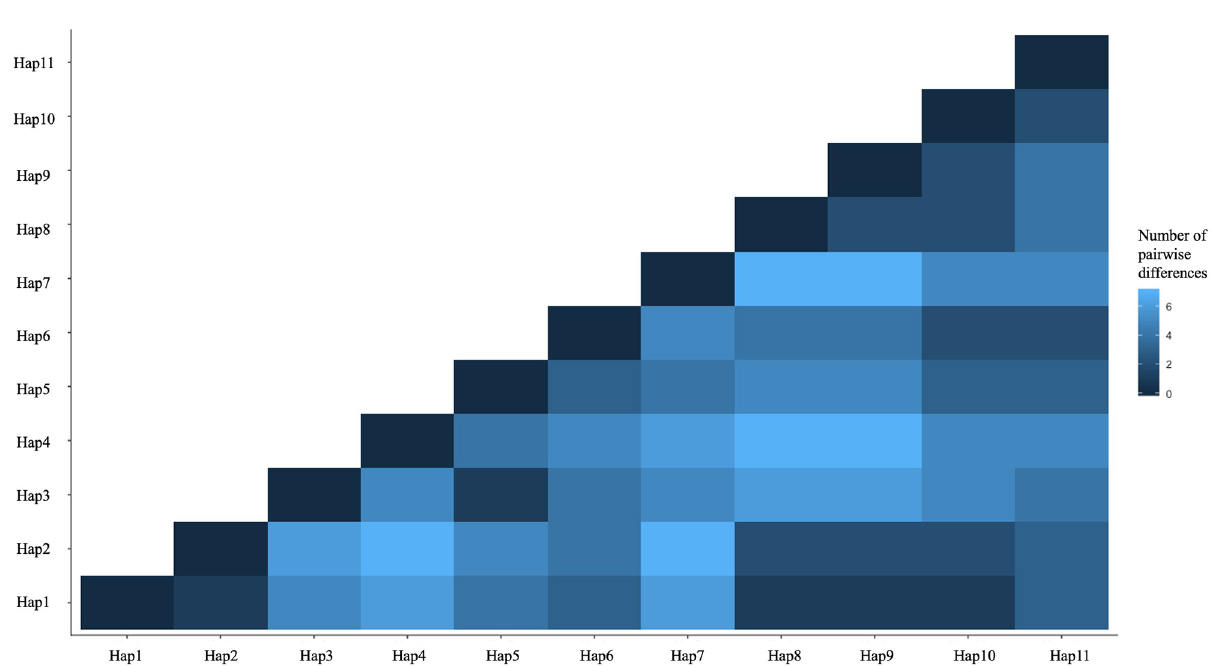
Fig 4. Pairwise distance between the mtDNA control region haplotypes identified in 14 U.S. Department of Interior and Parks Canada Agency bison herds.